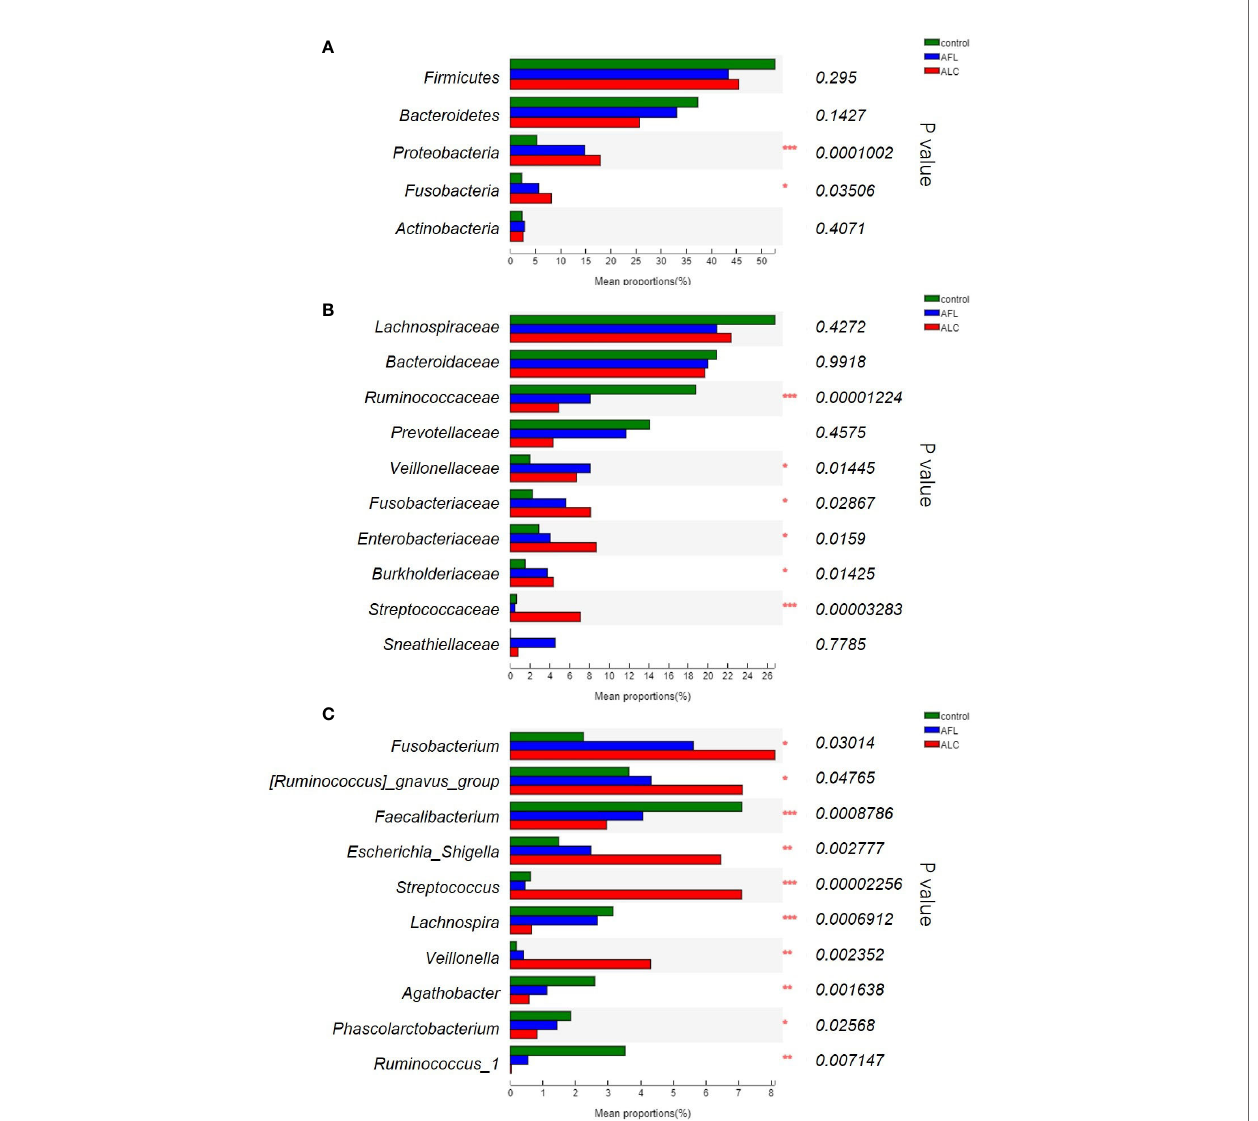
FIGURE 2 | The relative abundance of the gut microbiota between three groups. (A) At the phylum level, (B) at the family level, (C) signi fi cant differences between bacteria at the genus level. Statistical analysis was performed by the Kruskal – Wallis H test. *P < 0.05, **P < 0.01, ***P <